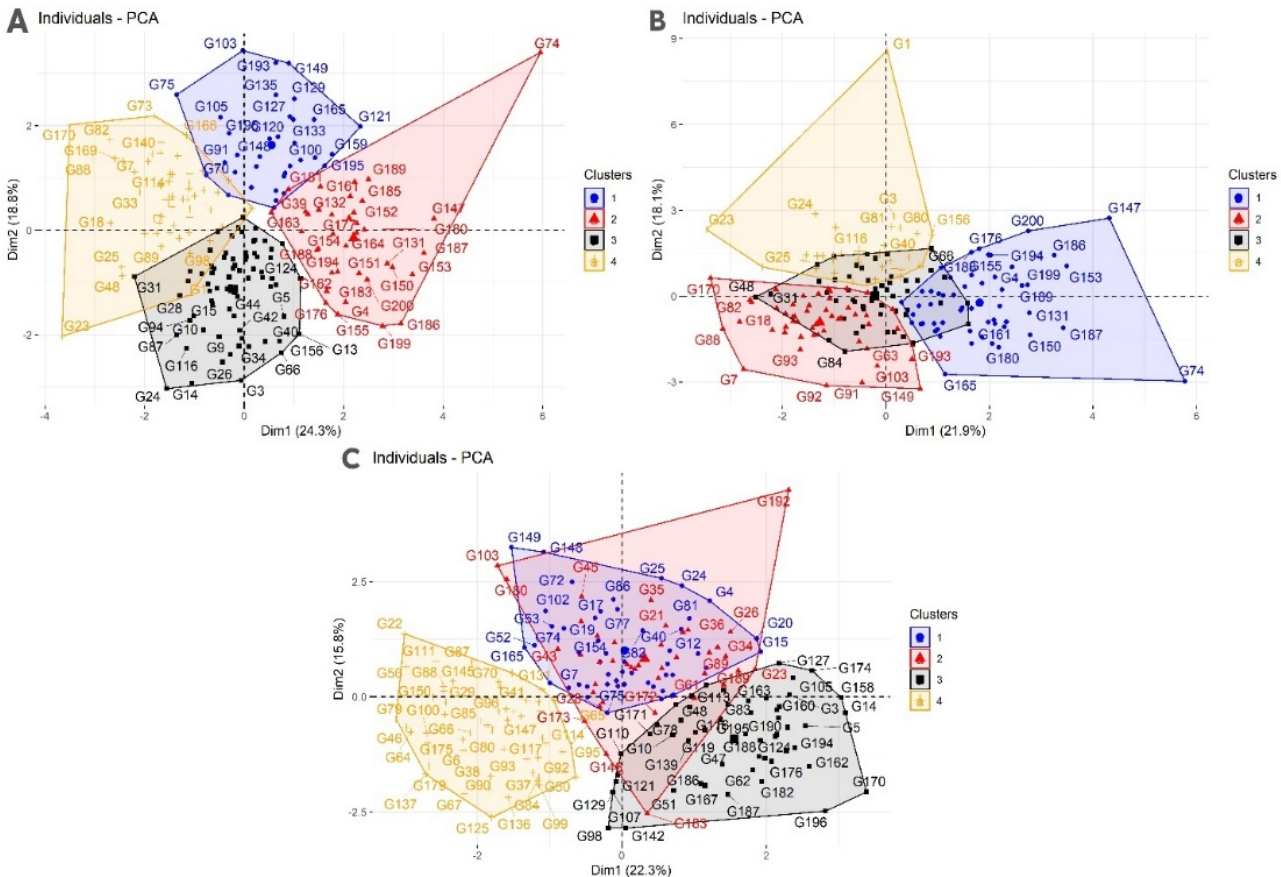
Figure 3. Cluster of 200 bread wheat genotypes grown during two seasons (2018 and 2019) under the rainfed regime ( A ) irrigated regime, ( B ) at Sidi Al-Aidi station, and rainfed regime at Merchouch station ( C ) in Morocco.